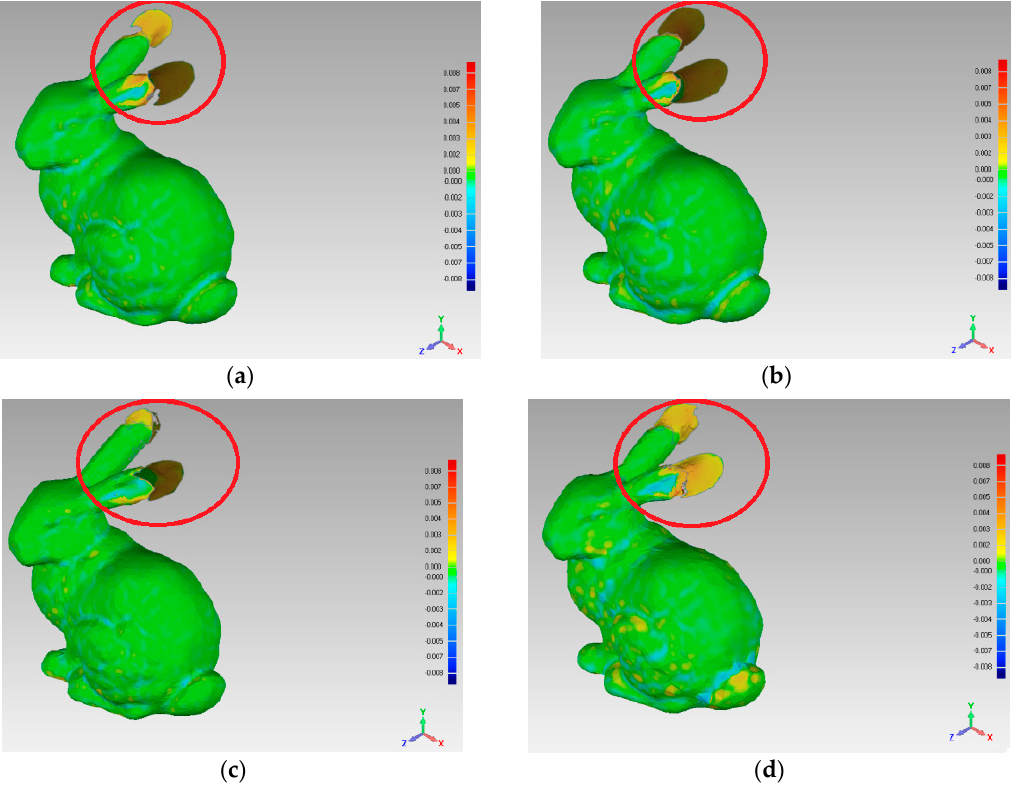
Figure 12. The simplification effect comparison using the bunny data set: ( a ) uniform-based simplification algorithm; ( b ) grid-based simplification algorithm; ( c ) curvature-based simplification algorithm; ( d ) FPPS.